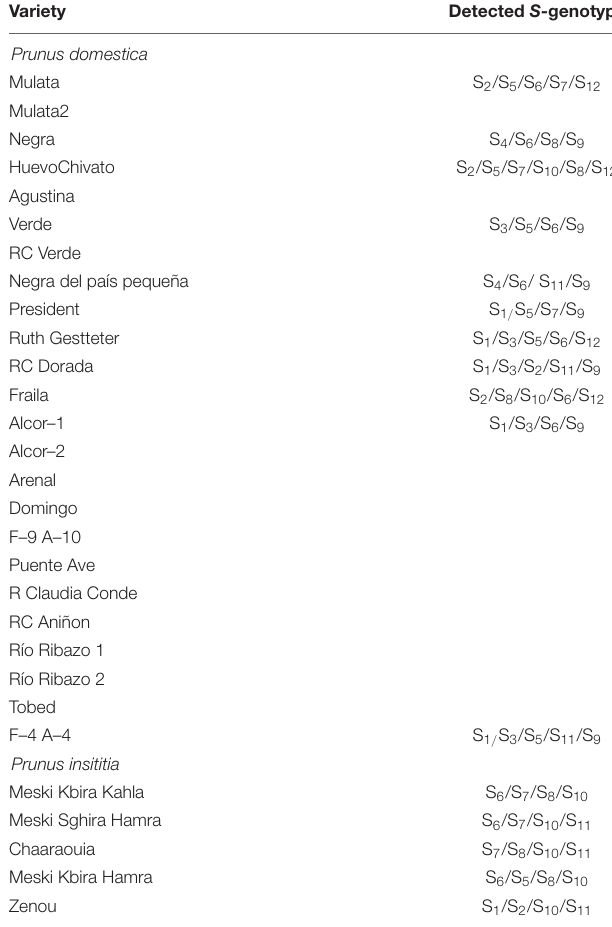
TABLE 5 | Identified S- genotypes and incompatibility groups for hexaploid Prunus domestica and Prunus insititia .